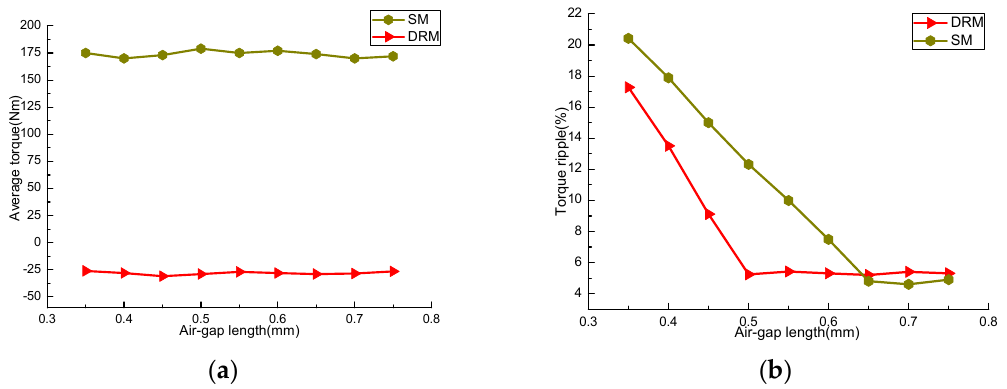
Figure 4. Average torque and torque ripple curve of stator machine (SM) and double-rotor machine (DRM) with different air-gap length: ( a ) Average torque; ( b ) Torque ripple.